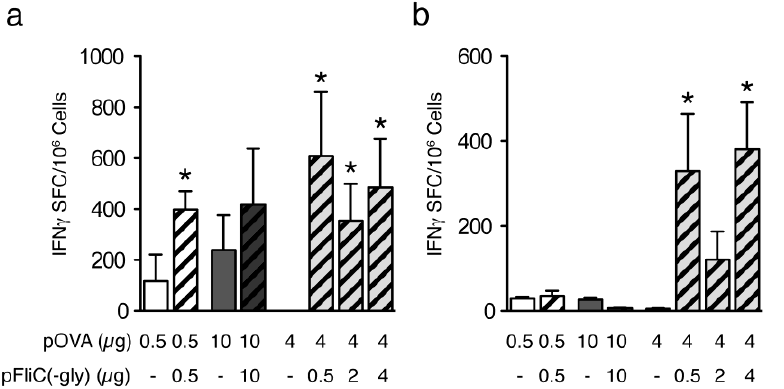
Figure 4. Class I- and Class II-dependent T cell responses to OVA. IFN  ELISPOT analysis of splenic T cell responses to ( a ) Class-I and ( b ) Class-II MHC binding OVA peptides after vaccination. (White bars) g.g. (Dark Grey Bars) i.m. (Grey bars) i.na. immunized mice. Striped bars indicate the use of pFliC(-gly). Results are representative of two independent experiments ( n = 7–8 mice/group). Data is expressed as the calculated geometric mean of the Ag-stimulated cells minus unstimulated cells. The error bars represent SEM calculated from the mean SFC/10 6 splenocytes. Statistical analyses were conducted using a two-tailed Student t test. * Differences of the response relative to pOVA immunizations without pFliC(-gly) defined as p ≤ 0.05 were considered significant using an two-tailed unpaired student t